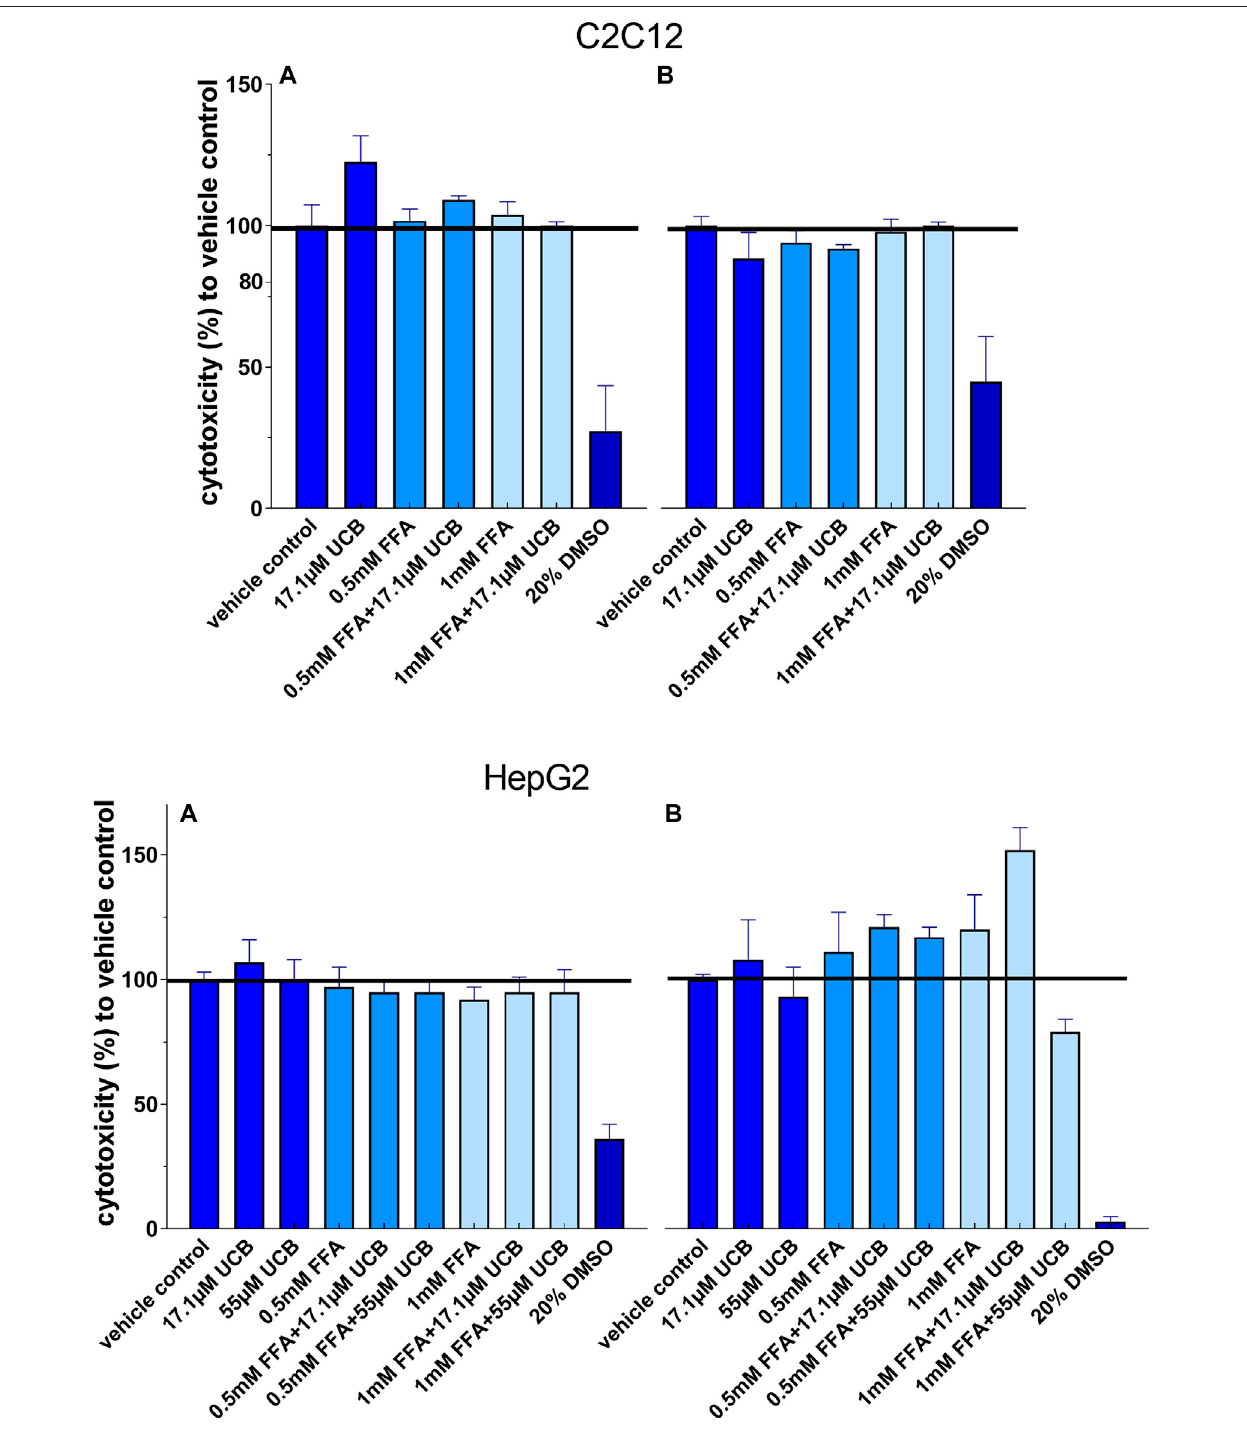
FIGURE 2 | None of the treatments was cytotoxic to C2C12 and HepG2 cells: Cells were incubated (A) at hypoglycaemic conditions for 12 h (C2C12) and 5 h (HepG2) or (B) with glucose for 24 h. Absorbance 485 nm, data are mean ± SD of at least n (cid:2) 2 (each in sextuplicate).